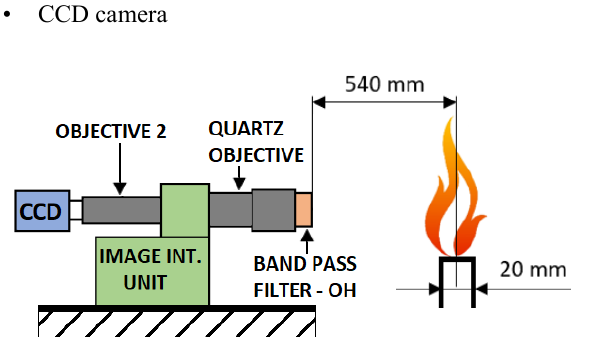
Fig. 2. Acquisition equipment set-up .